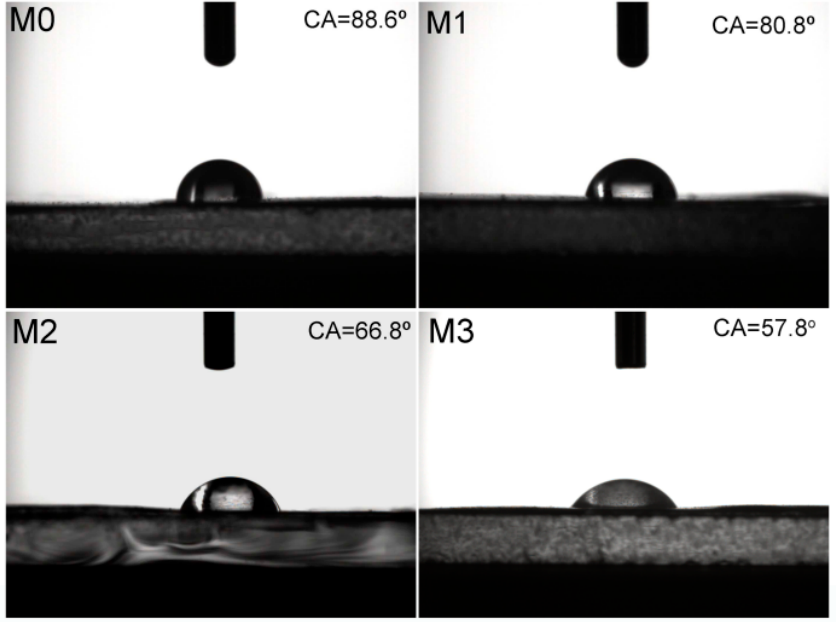
Figure 5. Water contact angles of membranes.